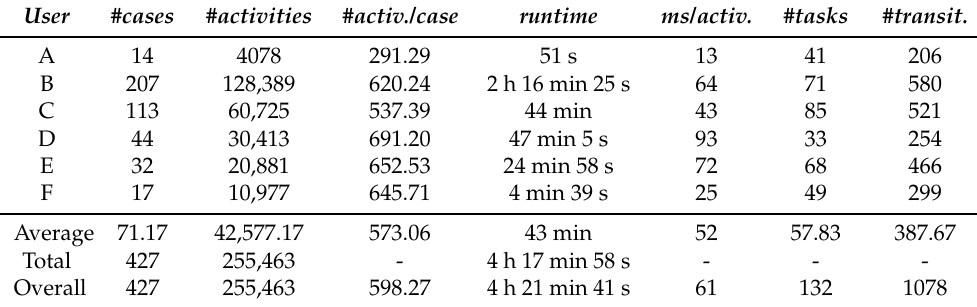
Table 1. Statistics on the training data and learning outcomes.